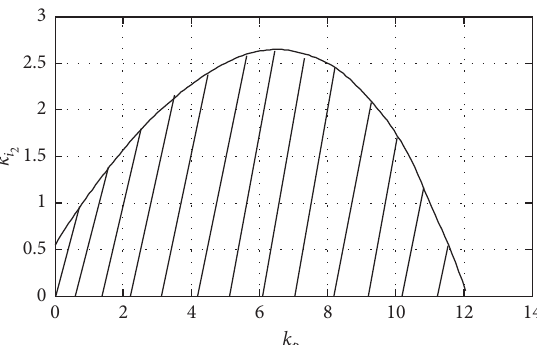
Figure 17: Value range of k